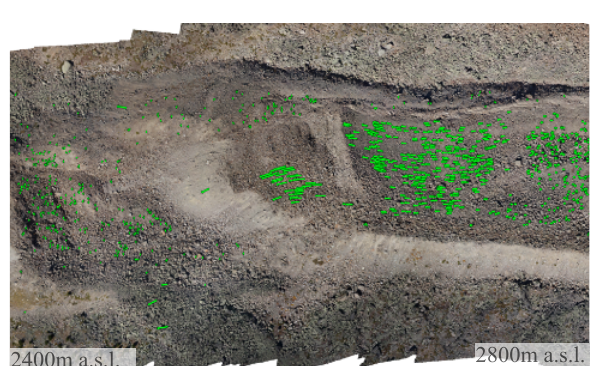
Figure 10. Tracked movement for the test site green: 2016-2017 red: 2017-2018